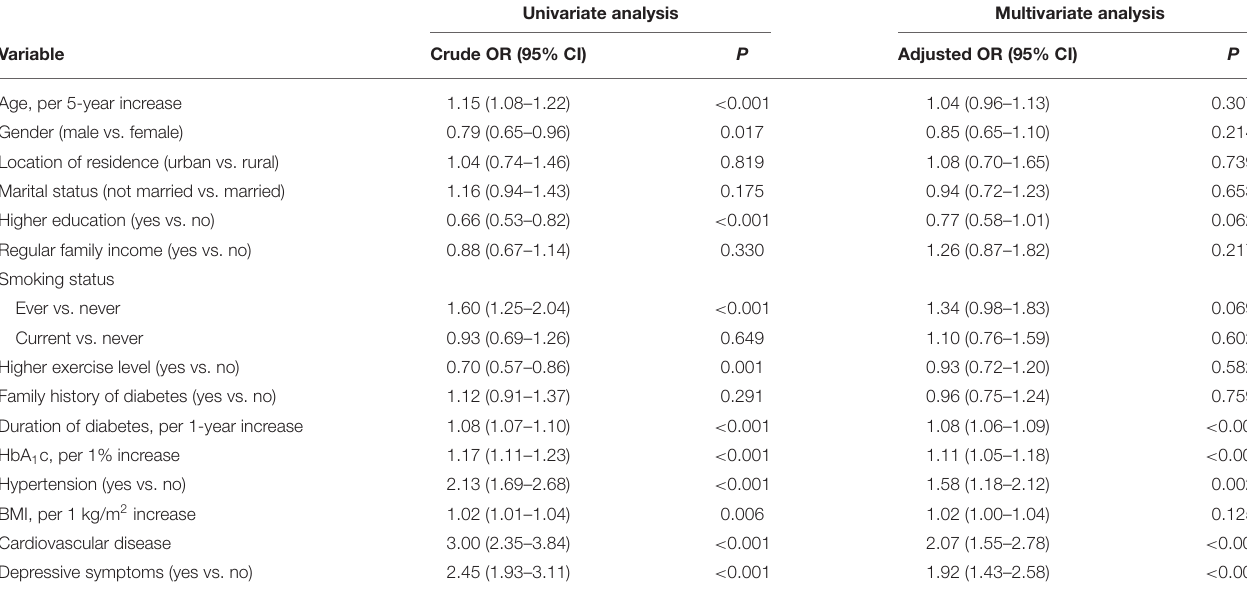
TABLE 3 | Odds ratios for diabetic neuropathy determined by multilevel mixed-effects logistic regression. Univariate analysis Multivariate